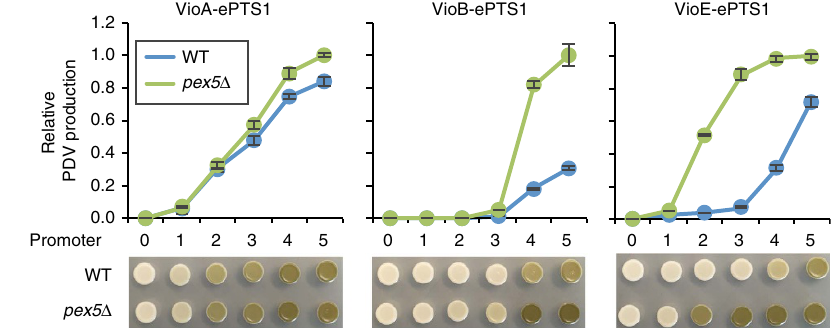
Figure 6 | Characterization of peroxisomal permeability in the PDV pathway. PDV was extracted from yeast strains expressing an ePTS1-tagged version of VioA, VioB or VioE together with untagged versions of the remaining two enzymes. Strains were constructed in either a wild-type (WT; blue lines) or pex5 D (green lines) background, with the ePTS1-tagged enzyme being expressed under a variety of promoters, numbered in rank order of expression strength: 0 ¼ no gene present, 1 ¼ pREV1, 2 ¼ pRNR2, 3 ¼ pRPL18B, 4 ¼ pTEF1, 5 ¼ pTDH3. Error bars represent the mean ± s.d. of four biological replicates. The extraction data are accompanied by spots showing the yeast after 48h growth